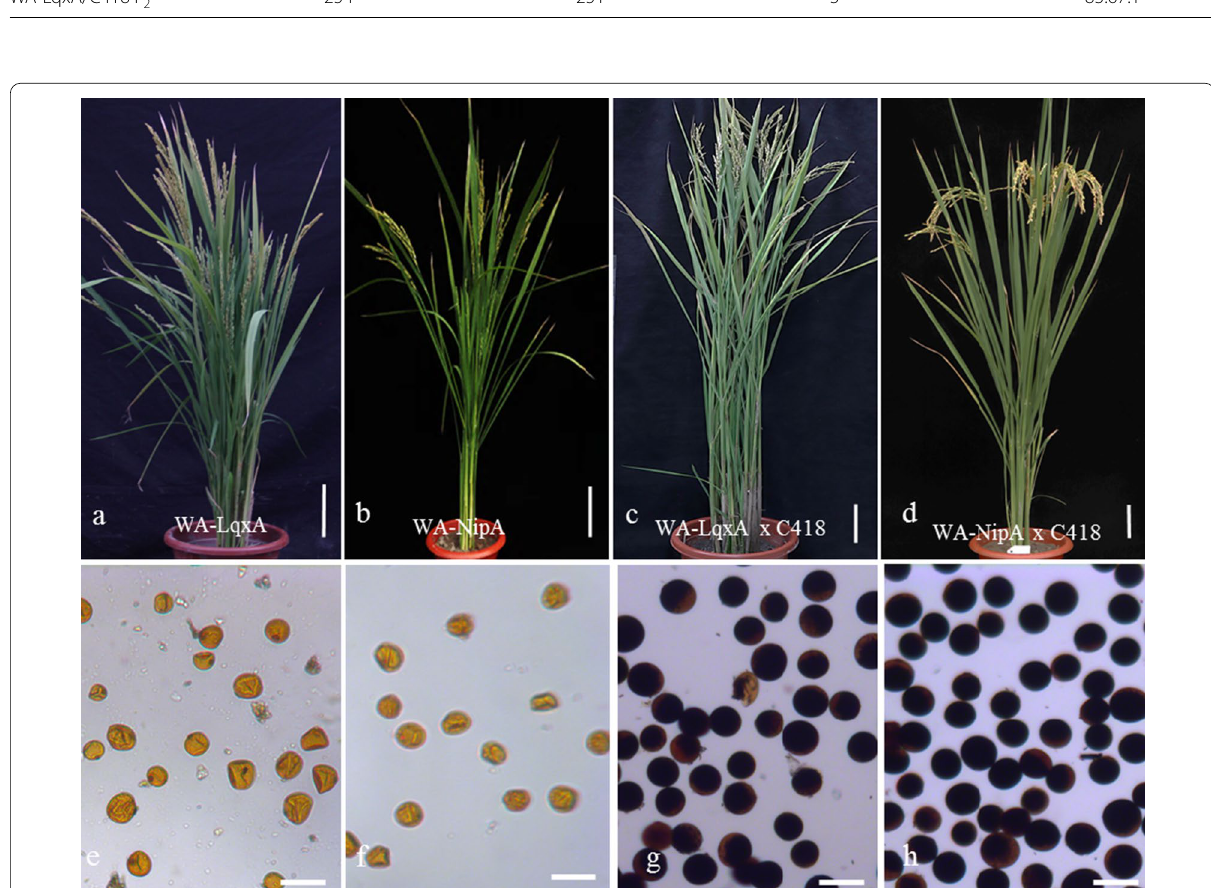
Fig. 1 Gross morphology of mature rice plants and pollen viability. a ‘WA-LiuqianxinA’ (WA-LqxA). b ‘WA-NipponbareA’ (WA-NipA). c , d F 1 plants of WA-LqxA C418, and WA-NipA C418. e – h Pollen grains stained with I 2 –KI from corresponding plants of WA-LqxA, WA-NipA, WA-LqxA × × and WA-NipA C418 F 1 , respectively. Scale bars 20 cm in a – d , 50 μm in e – × =